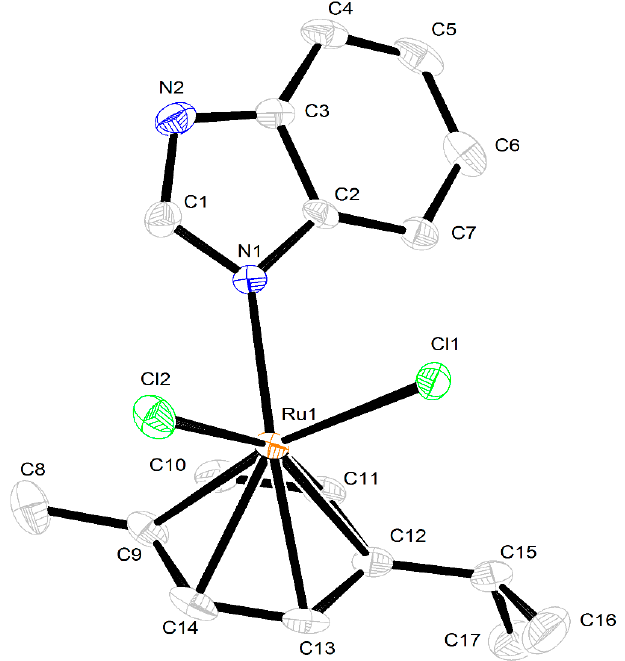
Figure 5. X-ray molecular structure of complex 3 . Thermal ellipsoids are drawn at a 50% probability level. Hydrogen atoms are omitted for clarity.